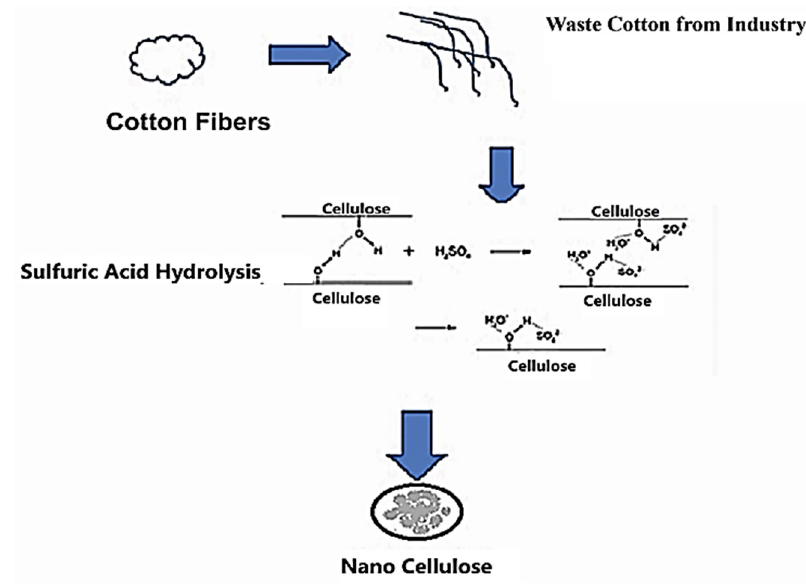
Figure 1. Nano-cellulose preparation process from waste